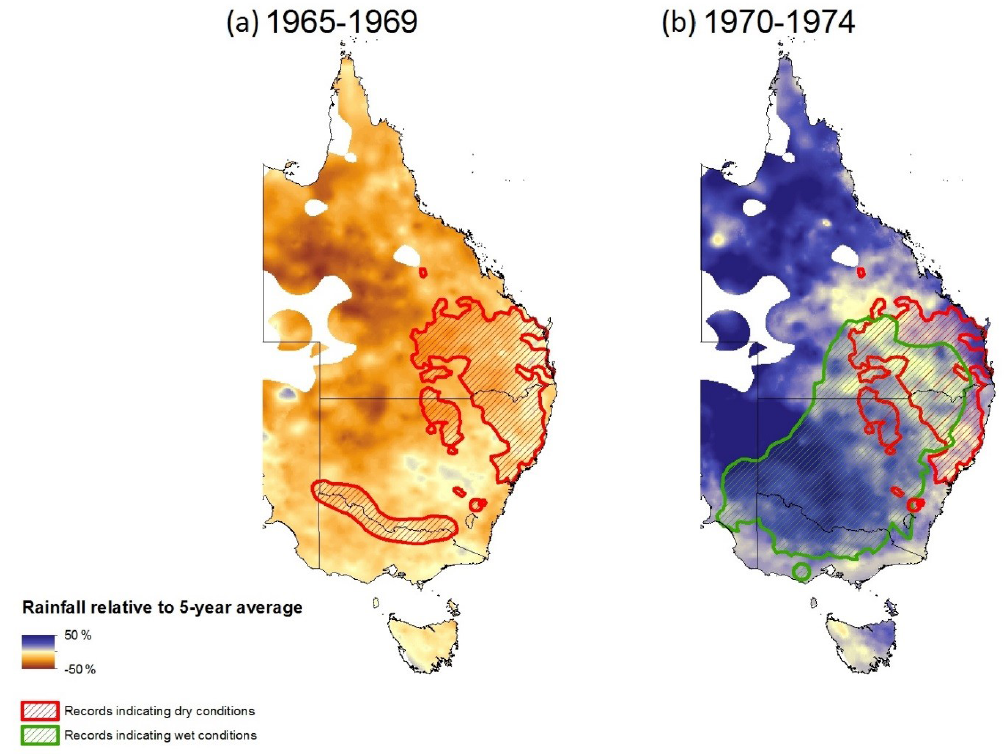
Figure 7. Australian Water Availability Project (AWAP) rainfall anomaly maps of 1965–1969 and 1970–1974, showing the spatial extent of wet/dry conditions suggested by palaeoclimate reconstructions of corresponding pre-instrumental periods.